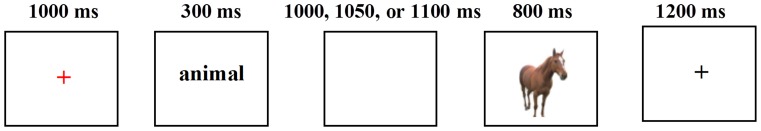
Example experimental data trial.During study 1, participants were shown a 1000 ms red fixation cross, followed by a 300 ms category probe. After a variable (1000, 1050, or 1100 ms) delay interval, participants were shown a target object for 800 ms.